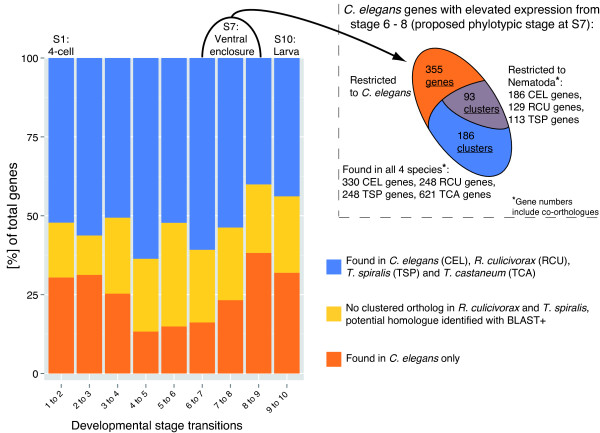
Many genes that are developmentally important in Caenorhabditis elegans were not present in Romanomermis culicivorax or Trichinella spiralis.R. culicivorax and T. spiralis orthologues of the 1,725 genes identified as important in embryogenesis in an analysis of gene expression in Caenorhabditis species [61] were sought. For each embryonic stage (1-10) in C. elegans we calculated the proportion of these genes that were apparently unique to the genus Caenorhabditis. The inset depicts numbers of two sets of genes and corresponding clusters that could play a role in a phylotypic stage of Nematoda or all Ecdysozoa, respectively.